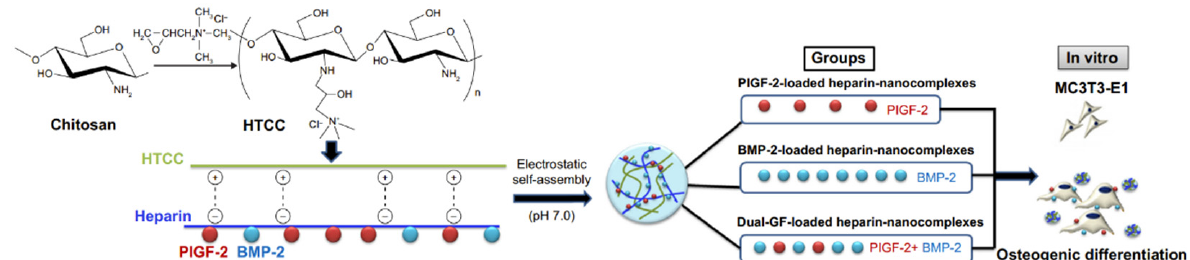
Figure 2. Schematic illustration of the fabrication mechanism and in vitro osteogenic effect of PlGF- 2-/BMP-2 nanocomplexes loaded with heparin-HTCC. Reprinted from [71], Copyright 2016 Dove Medical Press Limited.